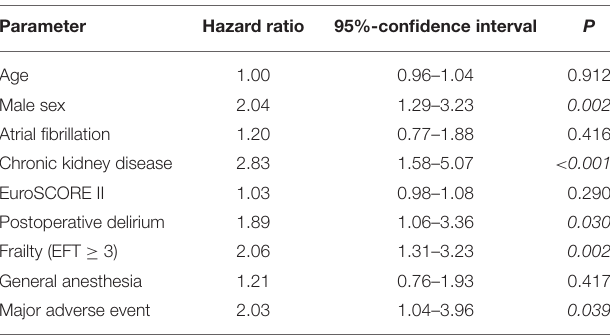
TABLE 3 | Predictors of 2-year